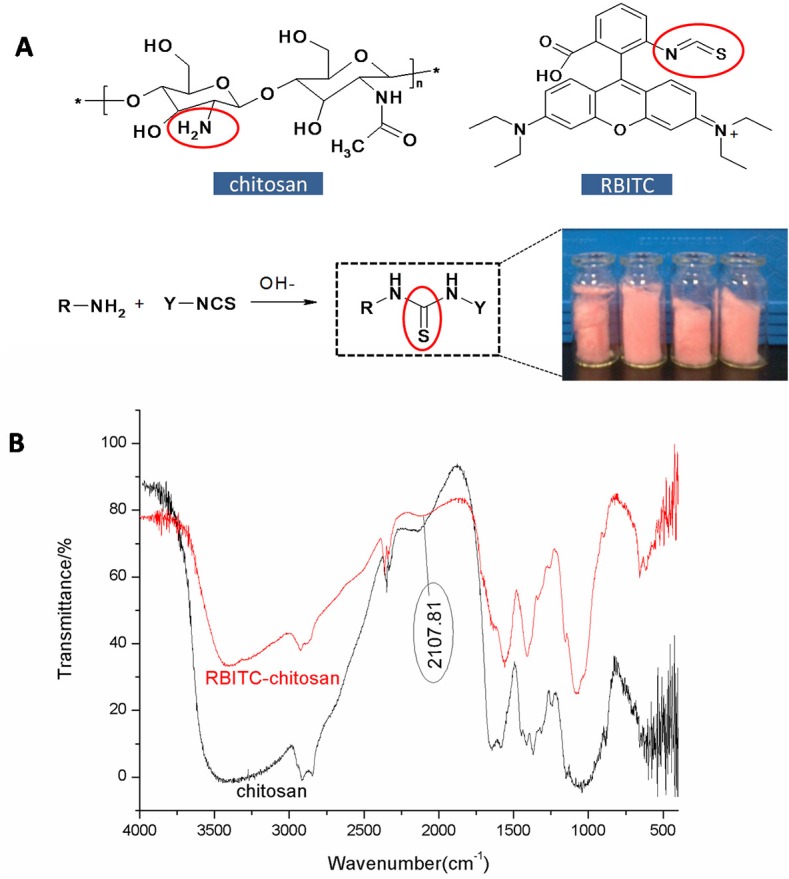
Identification of the RBITC-labeled chitosan.(A) Scheme of synthesis of the RBITC-labeled chitosan. (B) FTIR spectra of the unlabeled and RBITC-labeled chitosan.